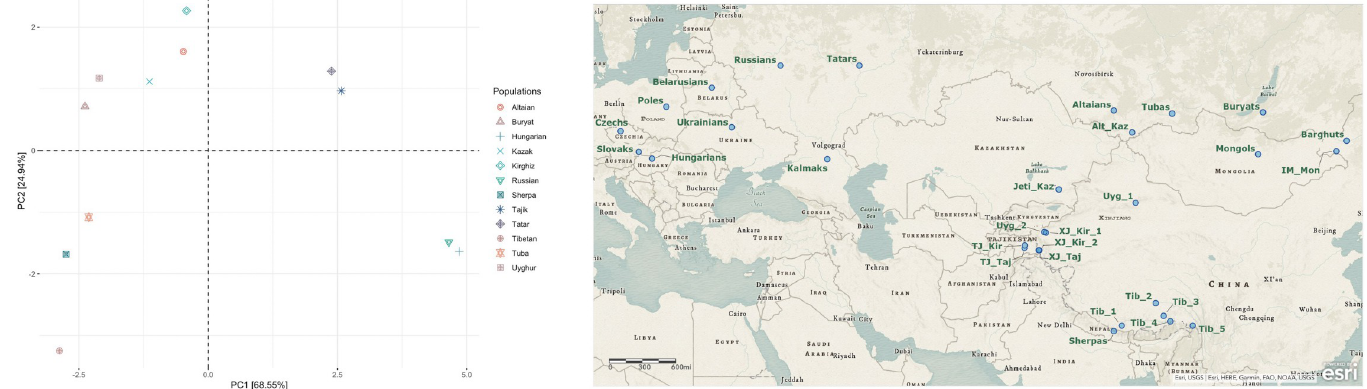
Fig 4. Geographic distribution of the human populations included in the analysis of mitochondrial genomes from Central Eurasia and the mtGenome pairwise F ST value based PCA. Notes on Fig 4: Populations having more than 30 sequences were included in the PCA analysis, and thus the dataset contained 1954 sequences from previous studies (Table 3) and 120 Kazak mtGenome sequences from Jetisuu. Sample IDs of the sequences were given in S7 Table. The pseudo-mtGenomes (N = 80) were excluded from the PCA analysis. Kazak [Kazaks from Jetisuu, Kazakhstan, i.e., Jeti_Kaz on the map ]; Alt_Kaz [Kazaks from the Altay Republic, Russia]; Buryat [Buryats from the Buryat Republic, Russia]; Hungarian [Hungarians from Hungary]; Kirghiz [Kirghiz from Xinjiang, China ( TJ_Kir ) and Kirghiz from Tajikistan ( TJ_Kir )]; Russian [Russians from Russia]; Sherpa [Sherpas from Zhangmu, Tibet, China]; Tajik [Tajiks from Xinjiang, China ( XJ_Taj ) and Tajiks from Tajikistan ( TJ_Taj )]; Tatar [Tatars from the Tatar Republic, Russia]; Tibetan [Ethnic Tibetans and other ethnic groups from Tibet, China ( Tib_1–5 )]; Tuba [Tubas from the Tuba/Tuva Republic, Russia]; Uyghur [Uyghurs from Xinjiang, China (Uyg _1–2 )].